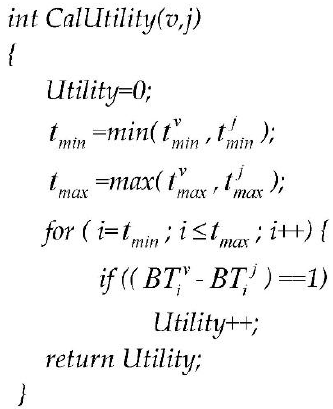
Figure 4. The CalUtility procedure for computing Utility.